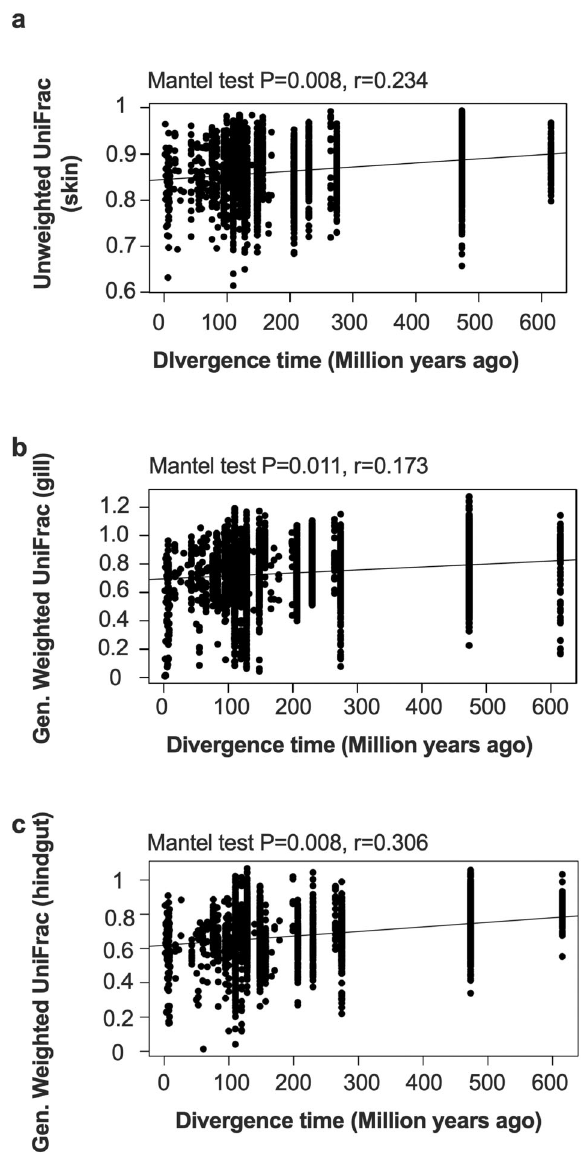
Fig.6|Evidenceforphylosymbiosisacross fi shbodysites. Effectofevolutionary distance (low divergence time indicates a short branch length or similar fi sh spe- cies) of all fi sh compared to a skin unweighted UniFrac distance, b gill generalized weighted UniFrac distance, c hindgut generalized weighted UniFrac distance. Comparisons performed using Mantel test with multiple testing by FDR. Diver- gence time between fi sh species calculated using timetree.org. Gen. Weighted UniFrac generalized weighted